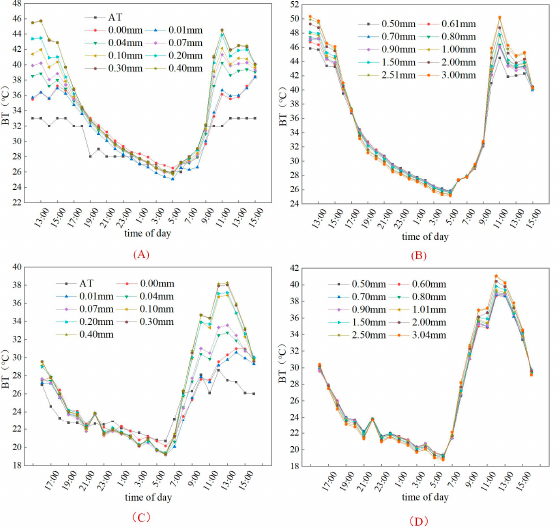
Figure 6. ( A ) Change of BT and air temperature (AT) of OFT (0.01–0.40 mm) in summer; ( B ) Change of BT of OFT (0.50–3.00 mm) in summer; ( C ) Change of BT and AT of OFT (0.01–0.40 mm) in autumn; ( D ) Change of BT of OFT (0.50–3.00 mm) in autumn.